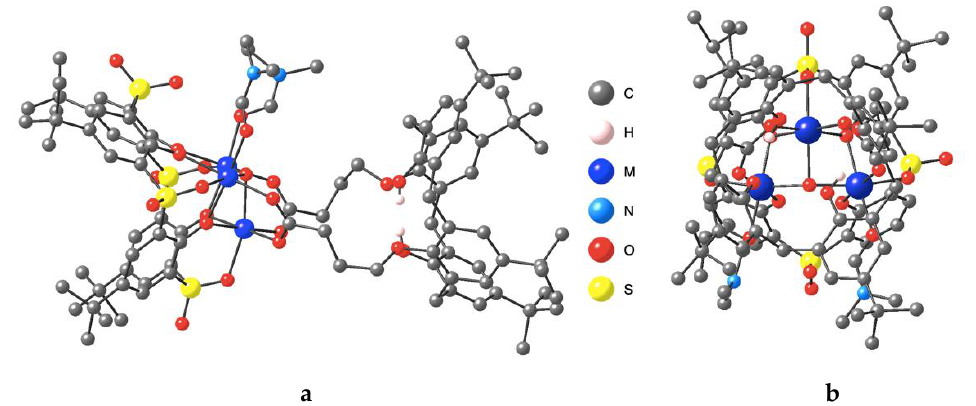
Figure 2. For M 3 (H 2 O)(DMF) 2 -( 2 -2H )- 3 (M = Co II , Ni II and Zn II ): view of the formed trinuclear complex, ( a ) along the b axis and ( b ) in the xOz plane. H atoms (excepting the protonated phenolic O atoms of 2 -2H 2 − ) and solvent molecules (excepting coordinated DMF molecules) are omitted for clarity. For bond distances and angles see the text and Table 2. Disordered fragments are not represented.